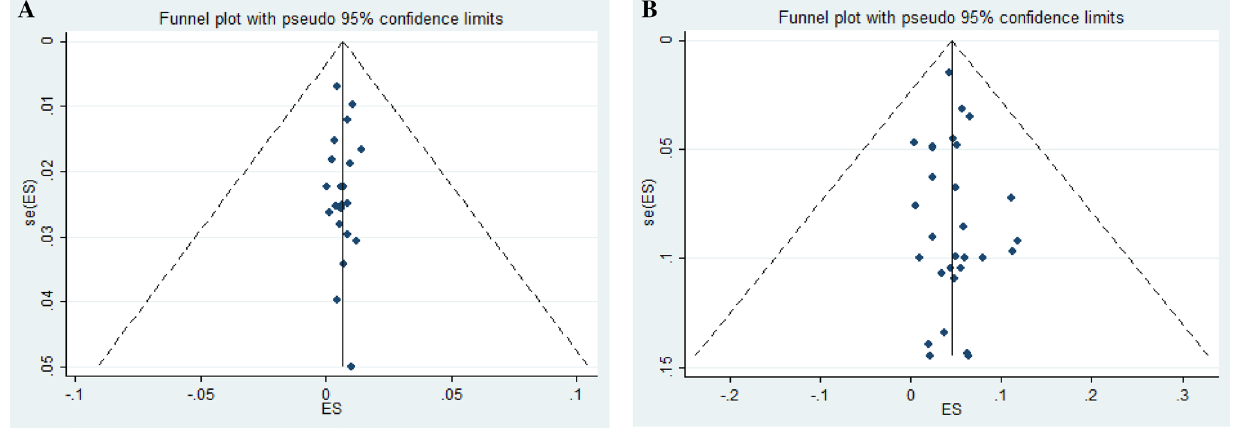
Figure 4. Funnel plot in not at-risk group ( A ) and at-risk group ( B